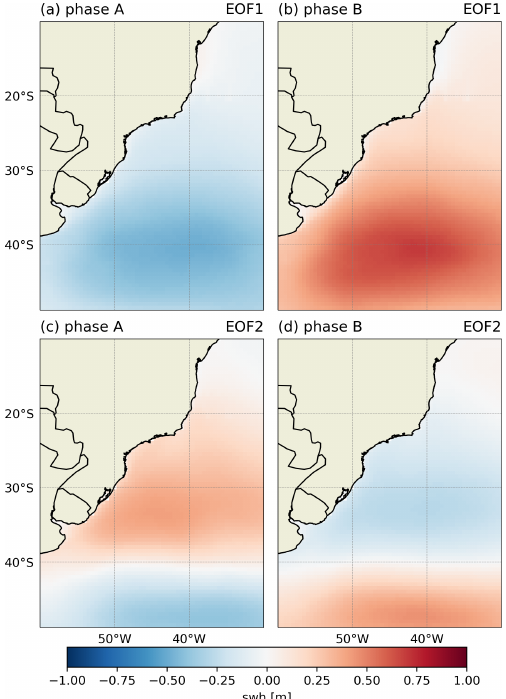
Figure C2. Composites of swh in phase A (a, c) and B (b, d) of the EOF1 (a, b) and EOF2 (c, d)